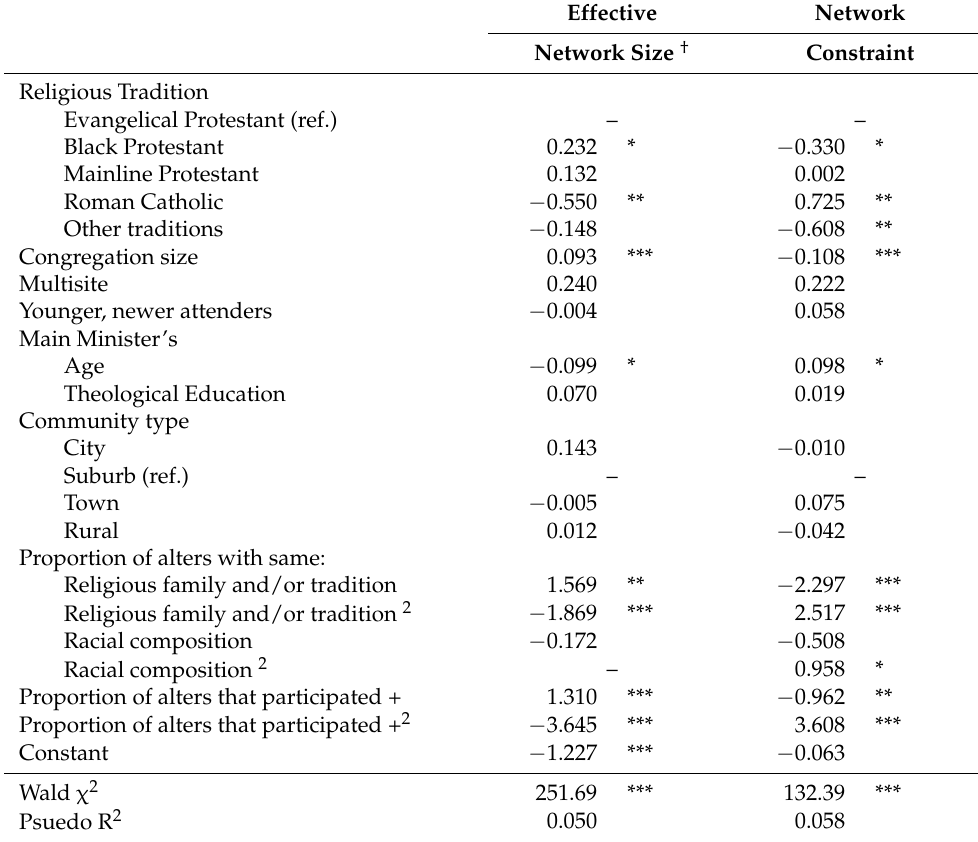
Table 3. Fractional logistic regressions predicting effective network size and network constraint for congregations with at least two participating